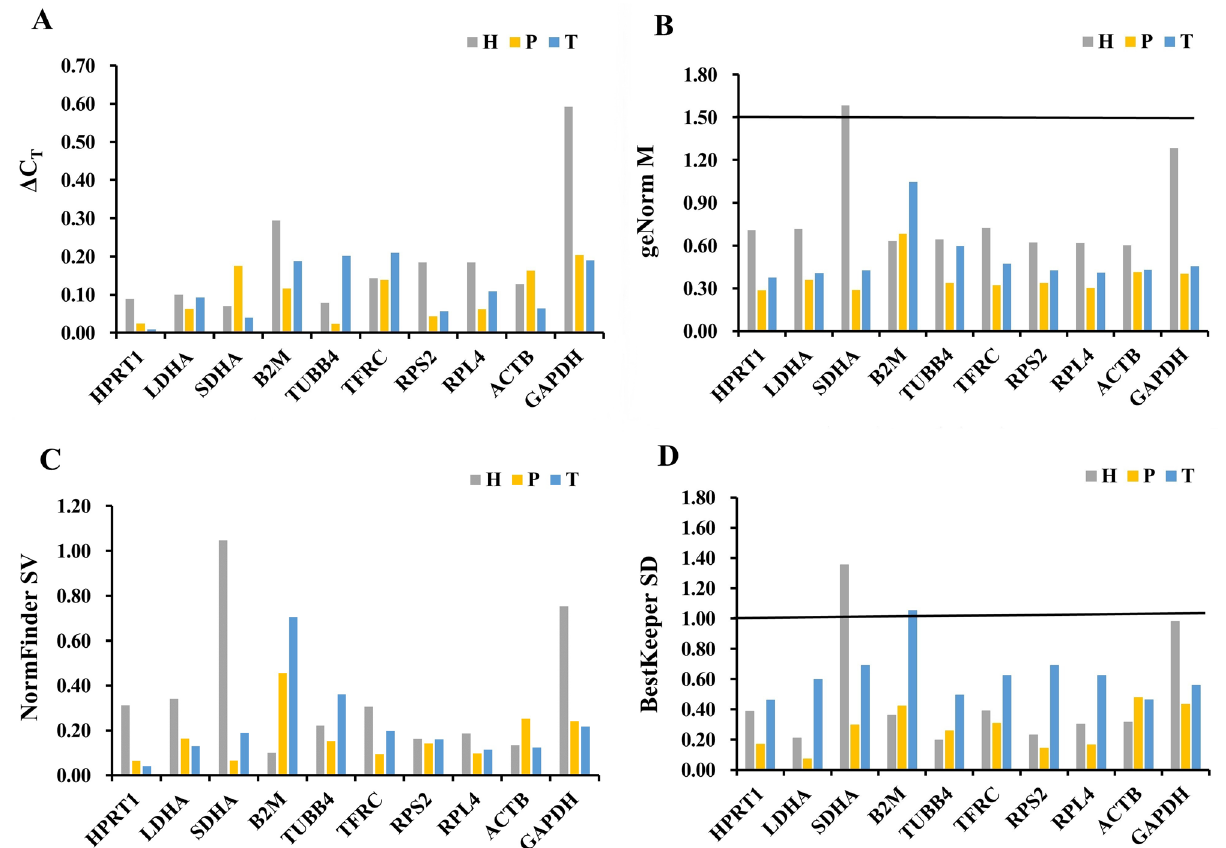
Figure 3. Analysis of reference gene stability based on different algorithms. ( A ) ΔCt; ( B ) geNorm; ( C ) NormFinder; ( D ) BestKeeper. H hypothalamus, P pituitary, T testis, M Average expression stability, SV stability value, SD standard